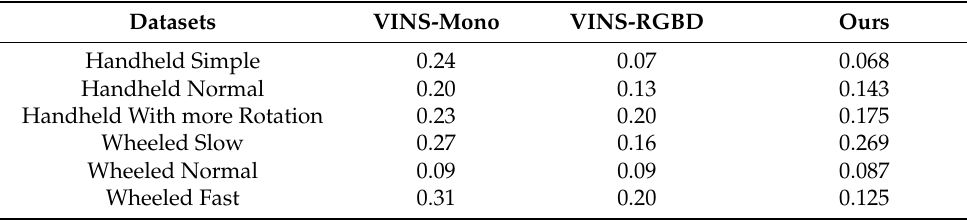
Table 4. RMSE comparisons between three different VIO methods in